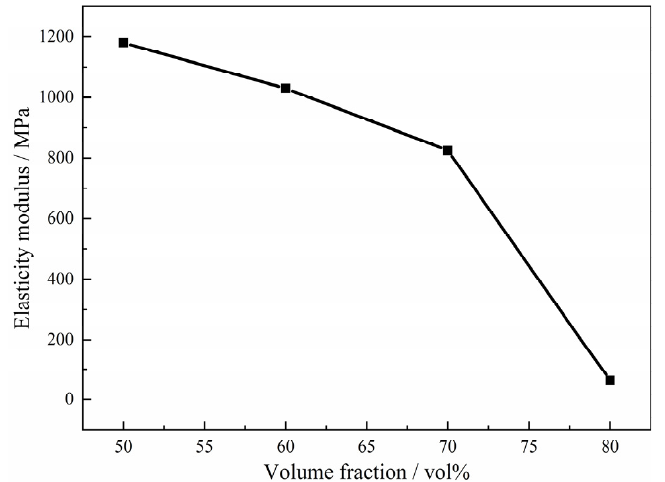
Figure 16 . Effect of fraction volume of magnesium powder on elastic modulus of porous titanium .